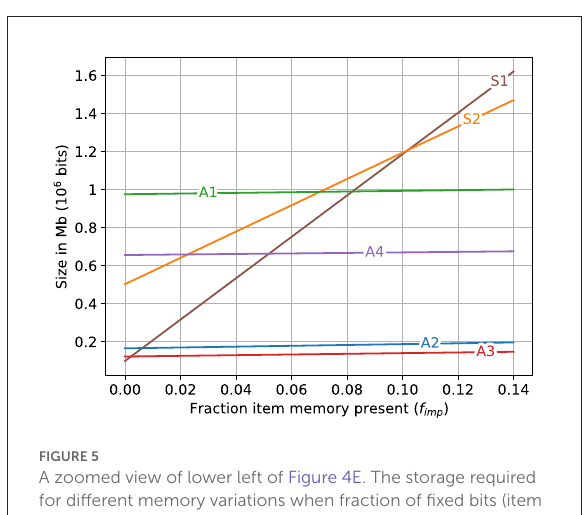
FIGURE5 A zoomed view of lower left of Figure 4E. The storage required for different memory variations when fraction of fixed bits (item memory and SDM’s address memory) present ranges as 0 ≤ f imp ≤